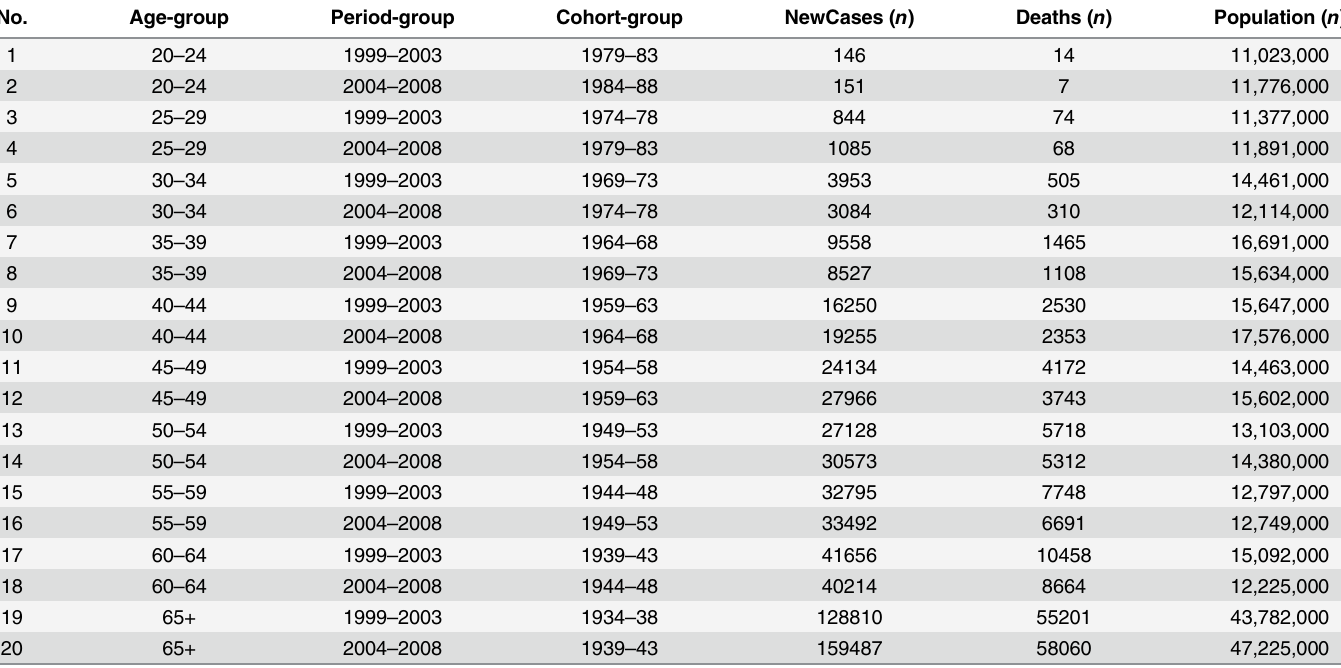
Table 1. Absolute Data Aggregates for Breast Cancer and Deaths due to Breast Cancer in German Women for Period 1999 –